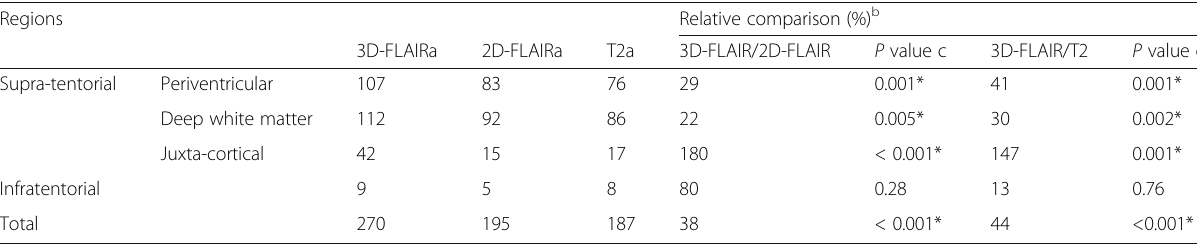
Table 2 Number of detected lesions in all patients in different brain regions by each used sequence and relative comparison of 3D- FLAIR versus 2D-FLAIR and T2 pulse sequences Regions